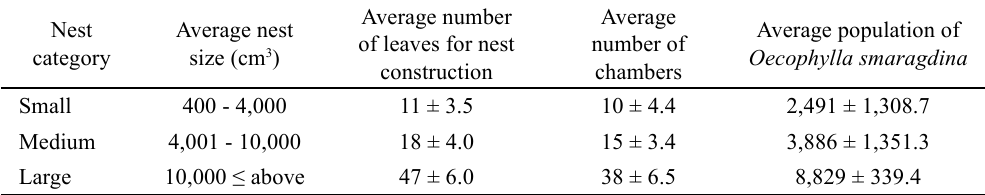
Table 3 . Nest size range showing the average number of leaves used, chambers and population of O. smaragdina . Mean ± SD, n = 6 for small and medium nest, n = 3 for large nest.